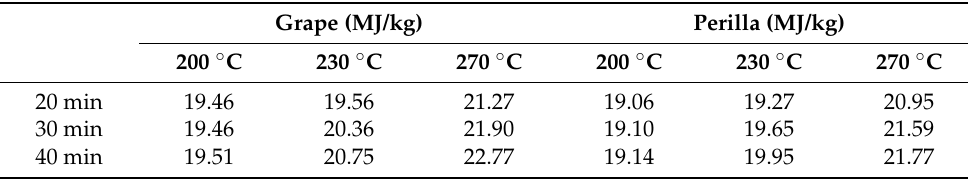
Table 2. Heating value of torrefied grape and perilla.